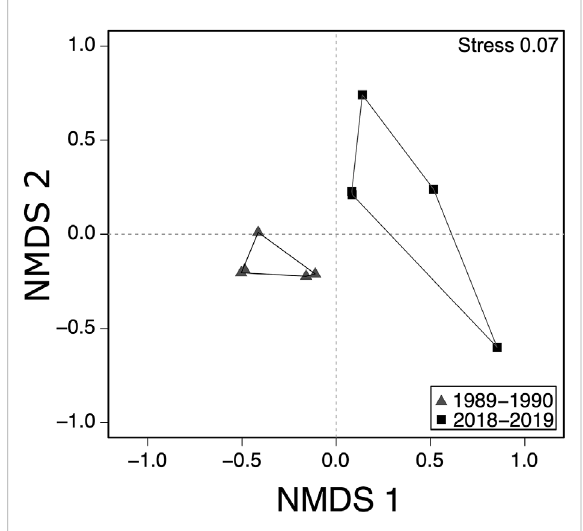
FIGURE 3 Non-metric multidimensional scaling (NMDS) ordination based on species composition between the 1989 – 1990 and (grey triangles) and 2018 – 2019 (black squares)